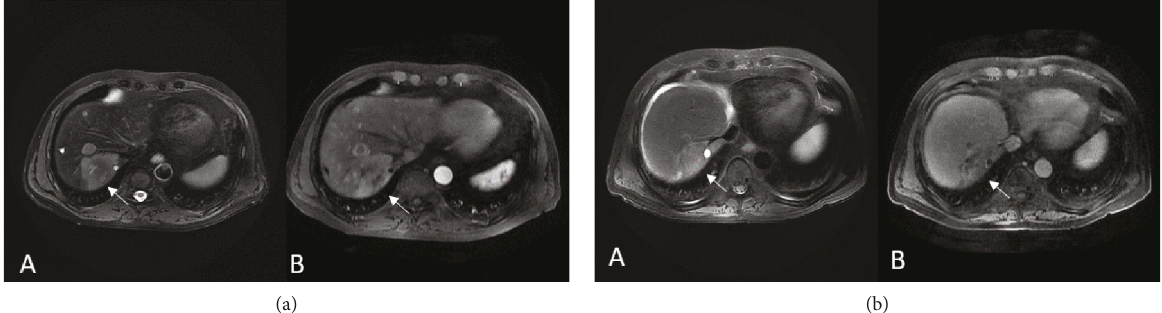
Figure 1: (a) Pretreatment scans (MRI). Axial T2 WI (A) and postcontrast (Eovist) Axial T1 WI (B) showing a 7 cm mass in the right liver lobe (arrows) and multiple smaller lesions in both liver lobes. (b) Posttreatment scans (MRI). Axial T2 WI (A) and postcontrast (Eovist) Axial T1 WI (B) show the decrease in size of the largest mass in the right liver lobe (arrows).